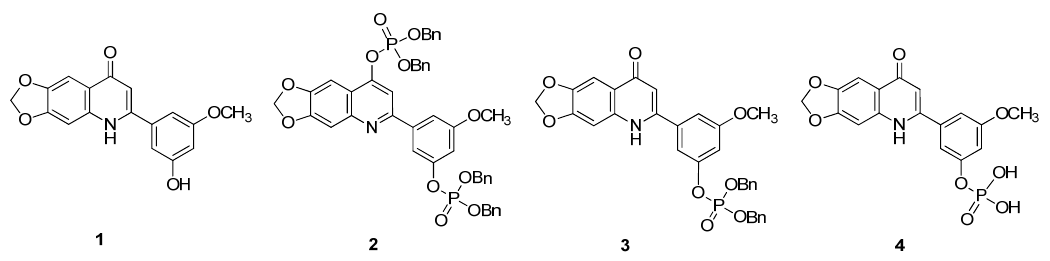
Figure 2. Structures of compounds 1 − 4 .